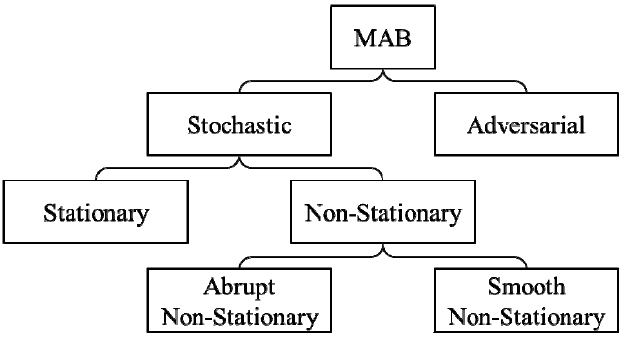
Figure 1. The taxonomy of multi-armed bandit (MAB) mode.